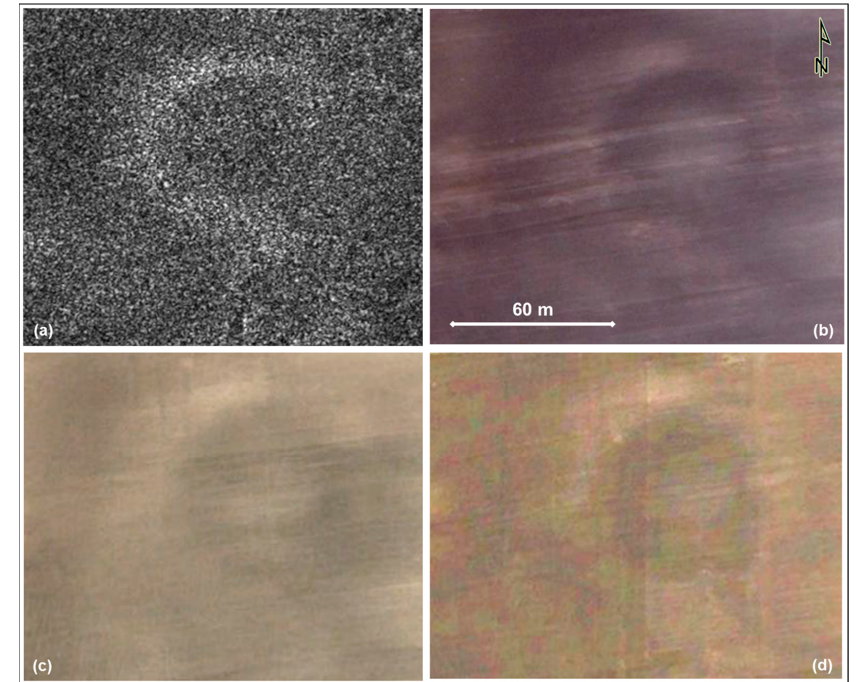
Figure 6. ( a ) Backscattering anomaly in bare ground observed in a COSMO-SkyMed Enhanced Spotlight image at 1-m ground resolution acquired in the summer with an incidence angle of 39°. The soil/damp mark is also visible in very high resolution optical satellite imagery (Google Earth © DigitalGlobe) acquired in ( b ) summer, ( c ) autumn and ( d ) winter. COSMO-SkyMed® Product © ASI—Italian Space Agency—2018. All Rights